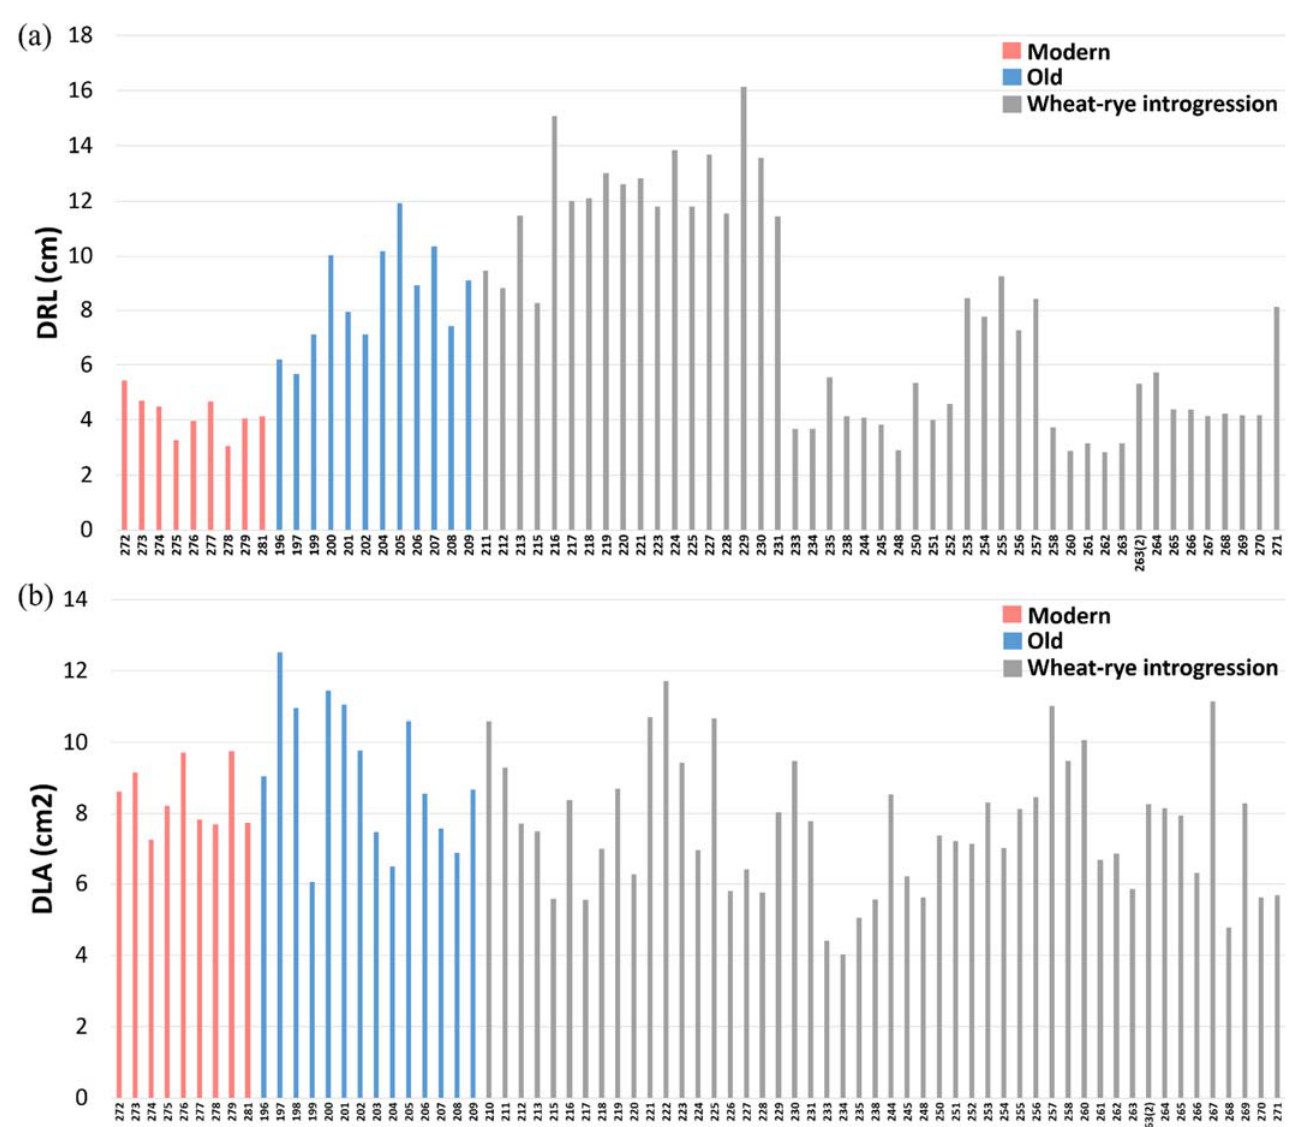
Figure 2. Comparisons of early crop vigour measured as ( a ) digital ‐ root length (DRL) and ( b ) digital ‐ leaf area (DLA) among genotypes including modern lines (approved cultivars and breeding lines received from company Lantmännen), old Swedish lines (cultivars released from 1928 to 1990) and wheat ‐ alien introgression lines (with 1R, 1RS, 2R and 3R). Due to the unstable germination power, five genotypes (198, 203, 210, 222, 226) were missing from the DLA data.